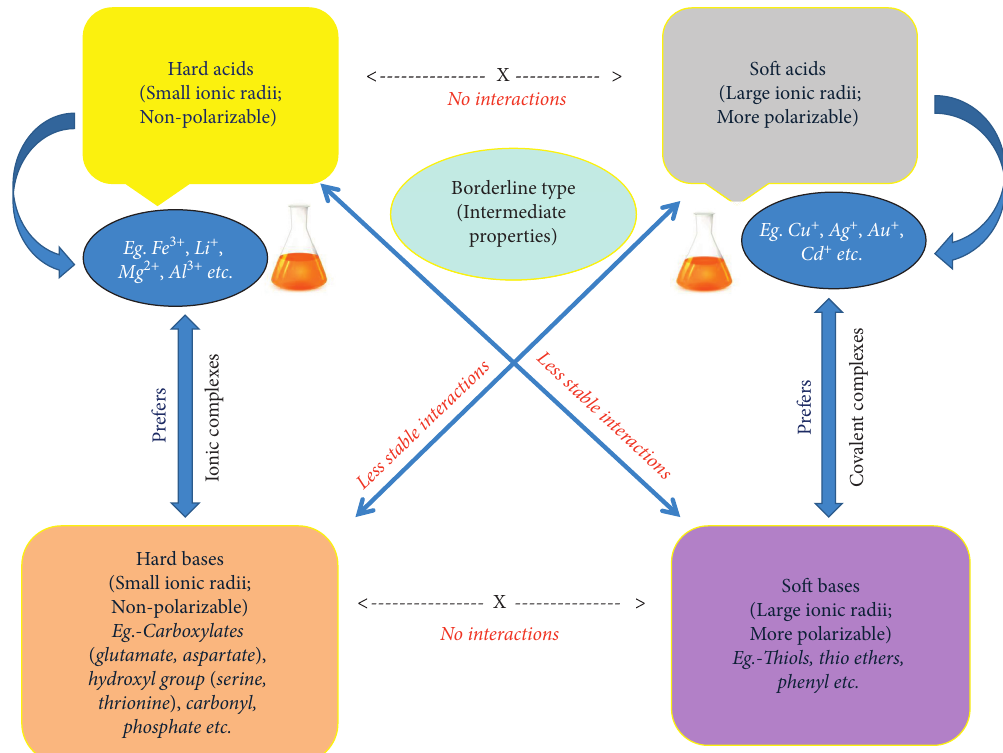
Figure 1: Hard and soft acid and base (HSAB) principle for probable complex formation between metal ions (acid) and base